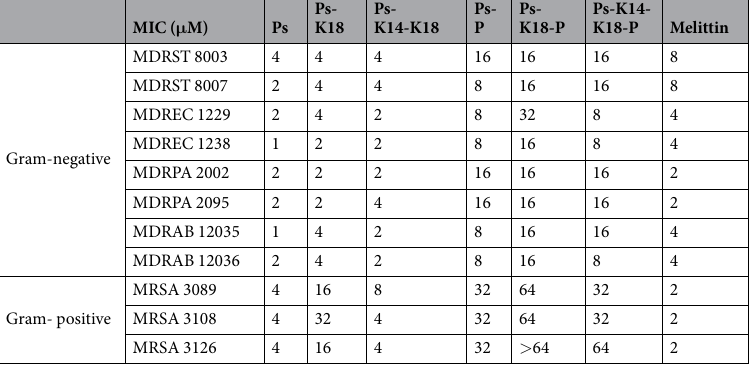
Table 3. Antimicrobial activities of the peptides against multidrug-resistant bacterial